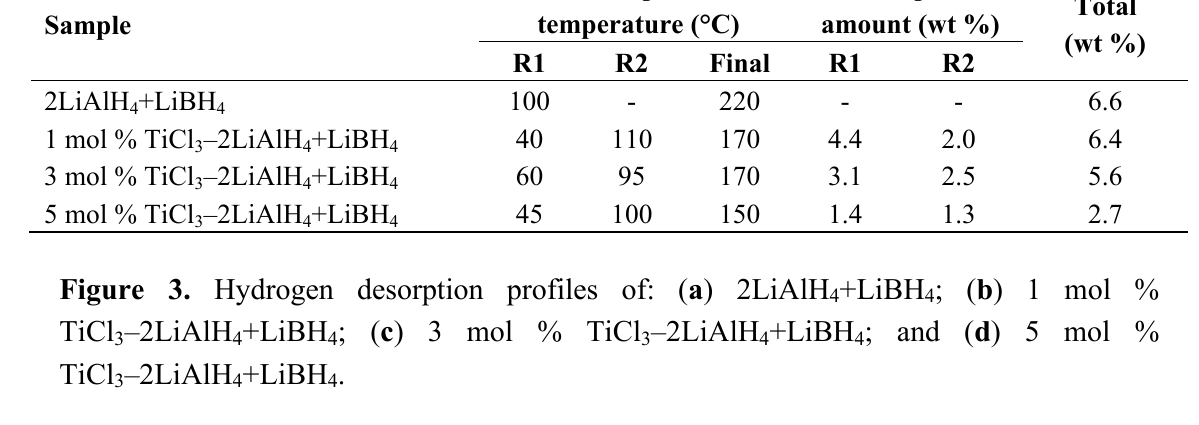
+LiBH ; ( c ) 3 mol % TiCl 4 4 +LiBH 4 4